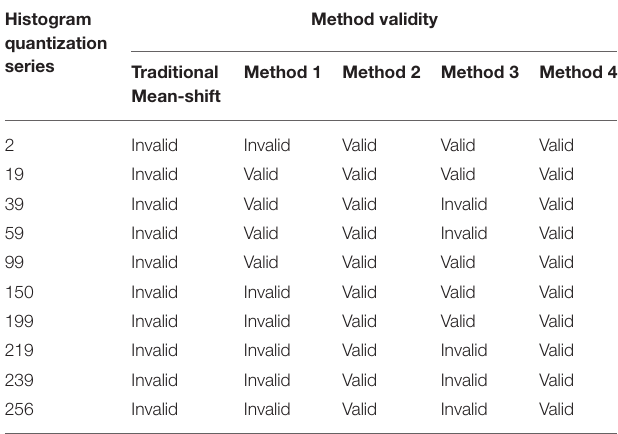
TABLE 1 | The relationship between the value of parameter m and the validity of the